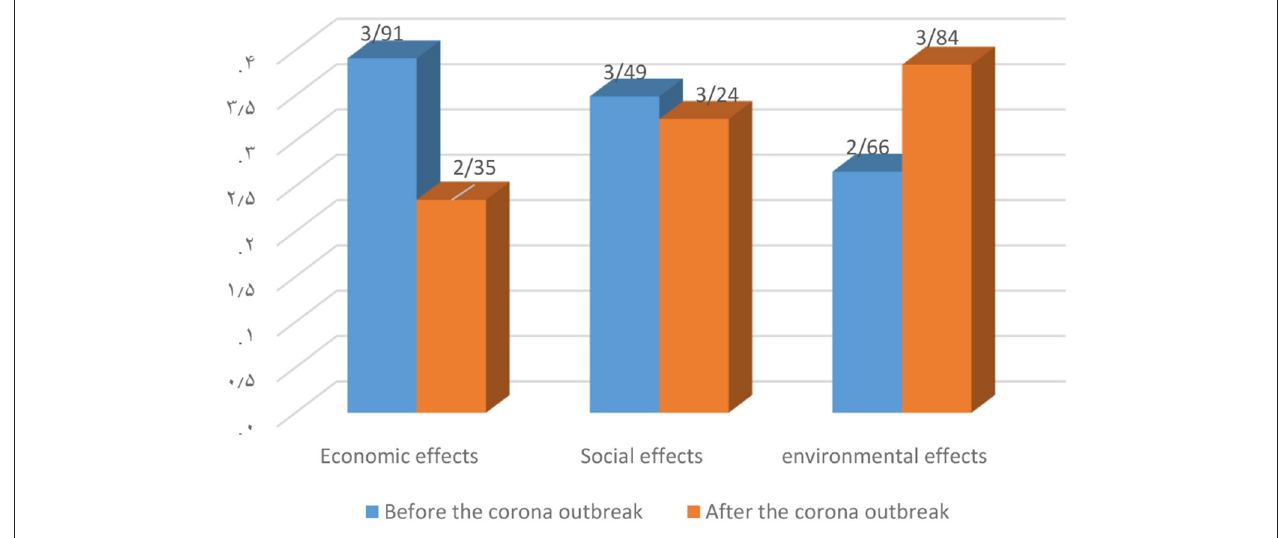
FIGURE 3 | Economic, social and environmental impact assessment chart, before and after the CORONA outbreak from the perspective of local stakeholders.